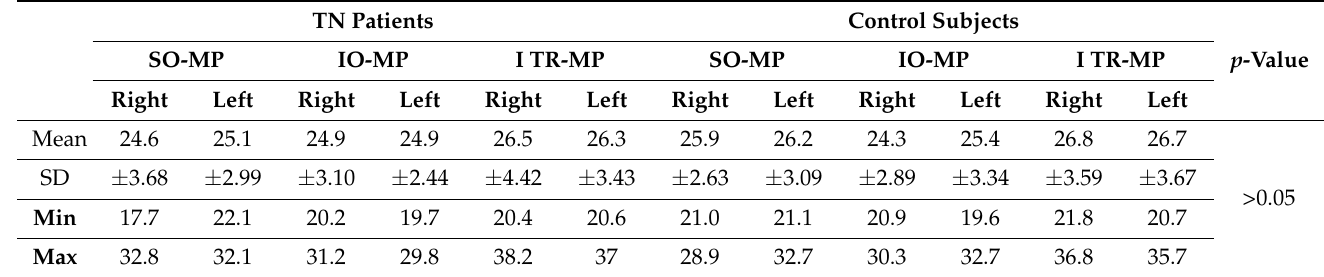
Table 2. The distances between the supraorbital, infraorbital foramen, impressio trigeminale, and median